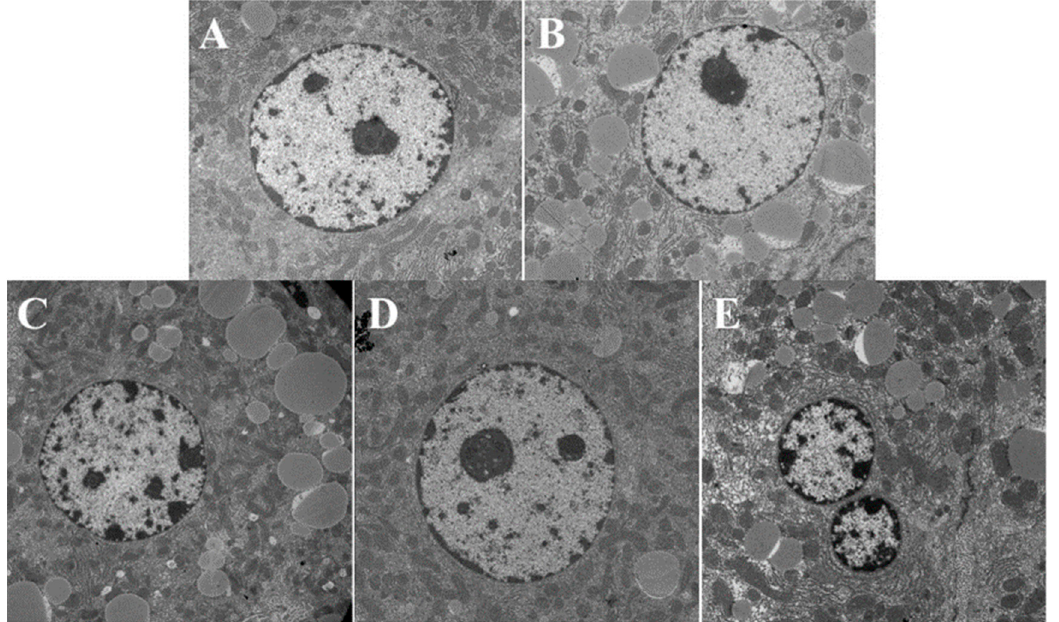
Figure 6. Effect of ORPS-1 (ORPS, Oudemansiella raphanipies polysaccharide) treatment on liver tissues in NAFLD mice (10,000× ultrastructure). ( A ) normal control group; ( B ) nonalcoholic fatty liver disease model group; ( C ) LOPRS-1, 50 mg/kg ORPS-1 + HFD; ( D ) MOPRS-1, 100 mg/kg ORPS-1 + HFD; ( E ) HOPRS-1, 200 mg/kg ORPS-1 + HFD. ORPS, Oudemansiella raphanipies polysaccharide; HFD, high-fat diet.